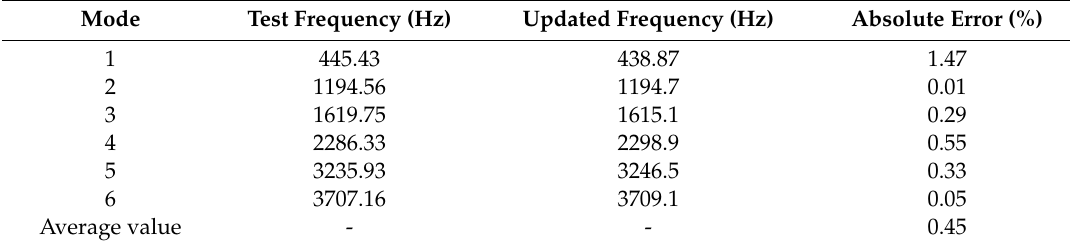
Table 7. The inherent frequencies from test and final FE model.